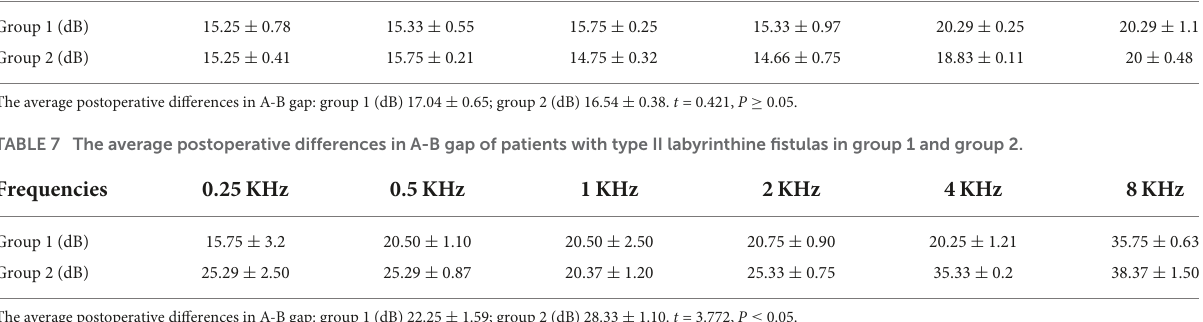
TABLE 8 Pre- and postoperative vestibular function examinations of type II labyrinthine fistula patients in group 1. Pre-operative caloric sMSPV ( ◦ /s) 26